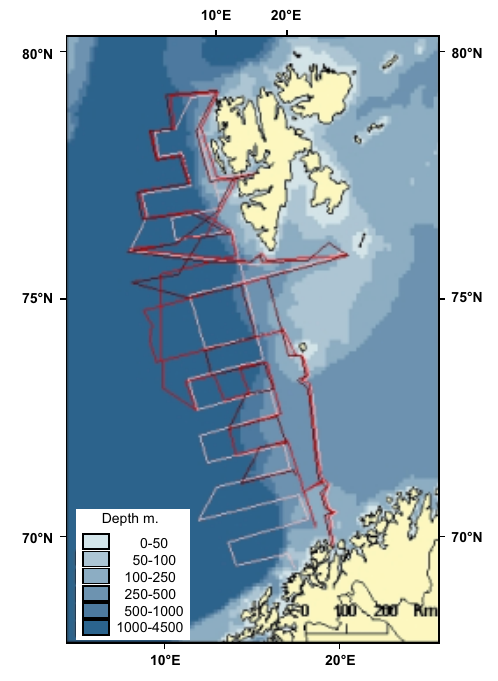
Fig. 1. Study area and cruise lines from the cruises in 2000 (light red), 2001 (red) and 2002 (dark